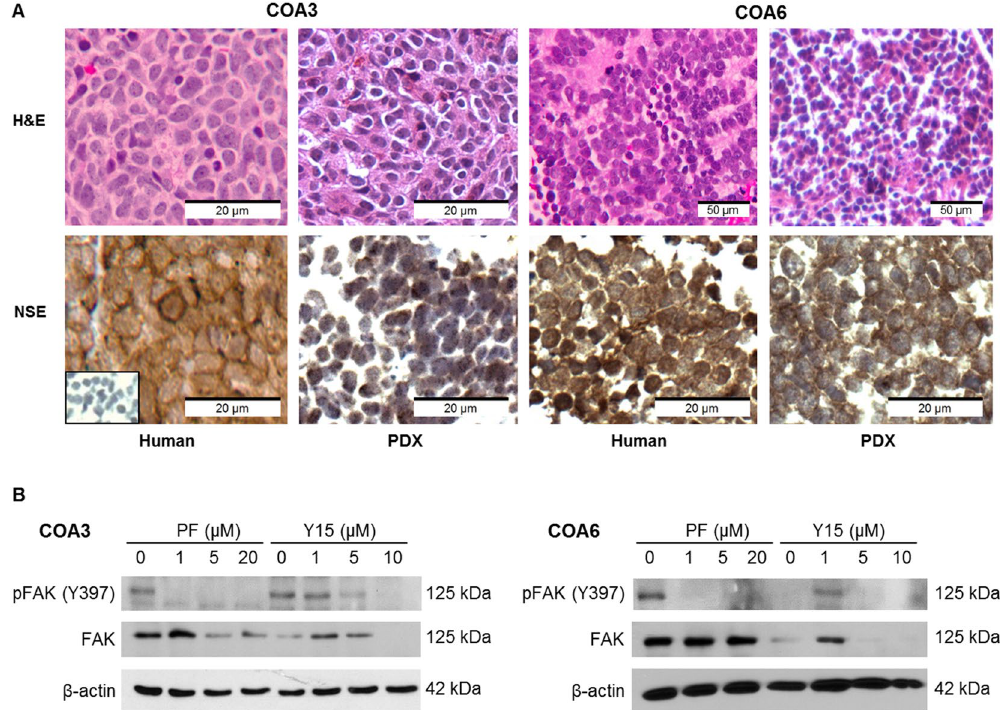
Figure 1. Human patient derived xenografts recapitulate the human tumor of origin and express FAK. ( A ) Hematoxylin and eosin staining ( top panels ) of the human specimens ( left ) and the tumors harvested from the mice ( right ) showed that the PDX tumors recapitulated the histology of the human specimens from which they were derived. Immunohistochemistry staining for neuron-specific enolase ( bottom panels ), a marker for neuroendocrine neoplasms, showed similar staining between the human specimens and the PDX tumors. ( B ) Immunoblotting of tumor lysates for total and phosphorylated (Y397) FAK demonstrated baseline expression of FAK and pFAK (Y397) in both COA3 and COA6 cells. In both cell lines treatment with FAK inhibitors PF and Y15 resulted in a decrease in both phosphorylated and total FAK in a dose-dependent